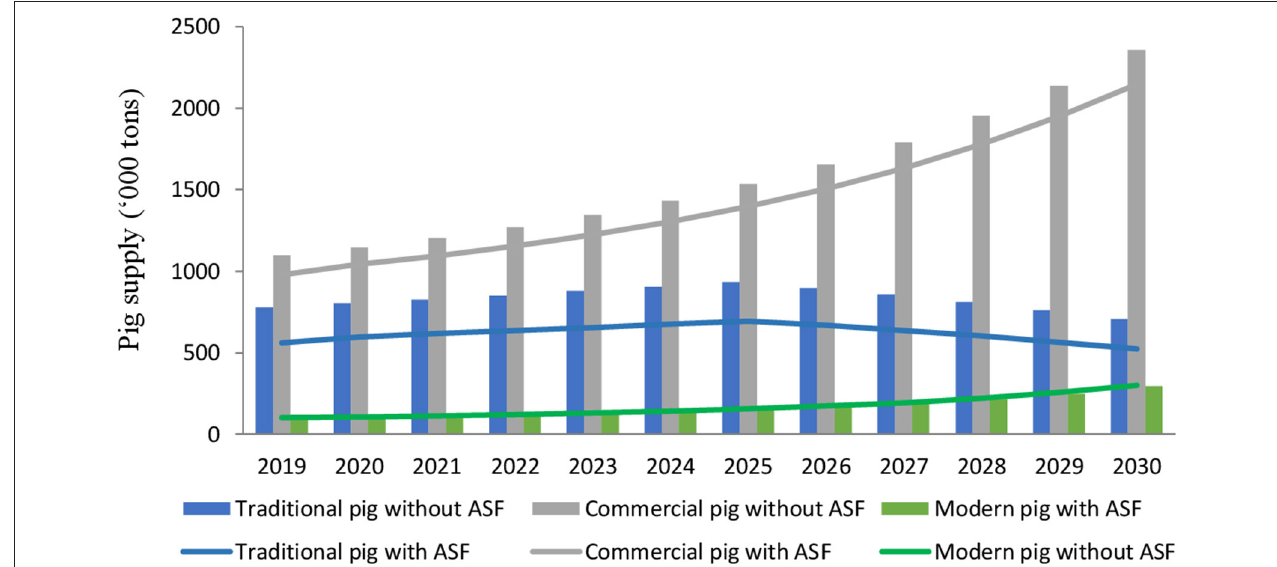
FIGURE 1 | Pig supply projection with and without ASF outbreak under baseline assumptions (5% reduction in demand from traditional and commercial sectors) (Source: Model simulations). The bars are the baseline, and the lines are the level post-ASF.